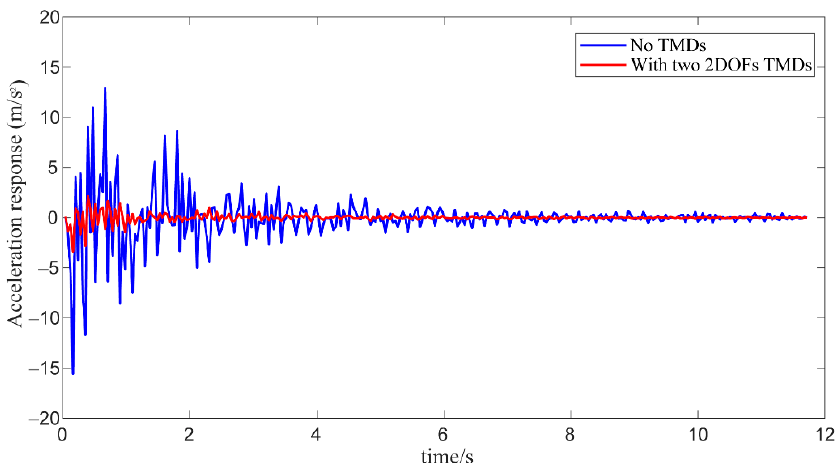
Figure 20. Experimental results: acceleration responses of the deck: blue line stands for without the TMDs; red line stands for with two TMDs.